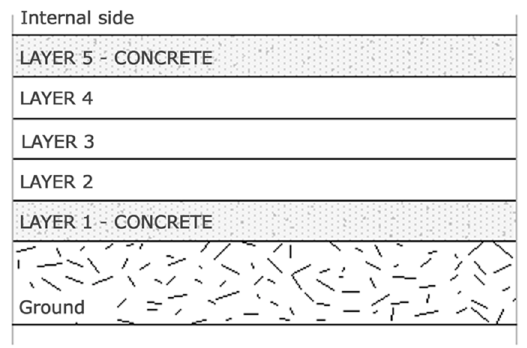
Figure 5. Case 1: Stratification of the slab-on-ground with concrete.